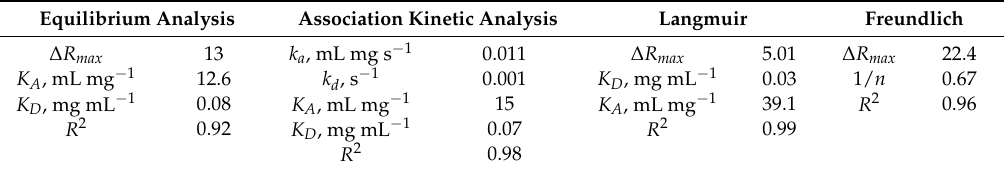
Figure 3. Adsorption isotherm models: Langmuir ( A ) and Freundlich ( B ). Table 1. All coefficients of kinetic analysis.